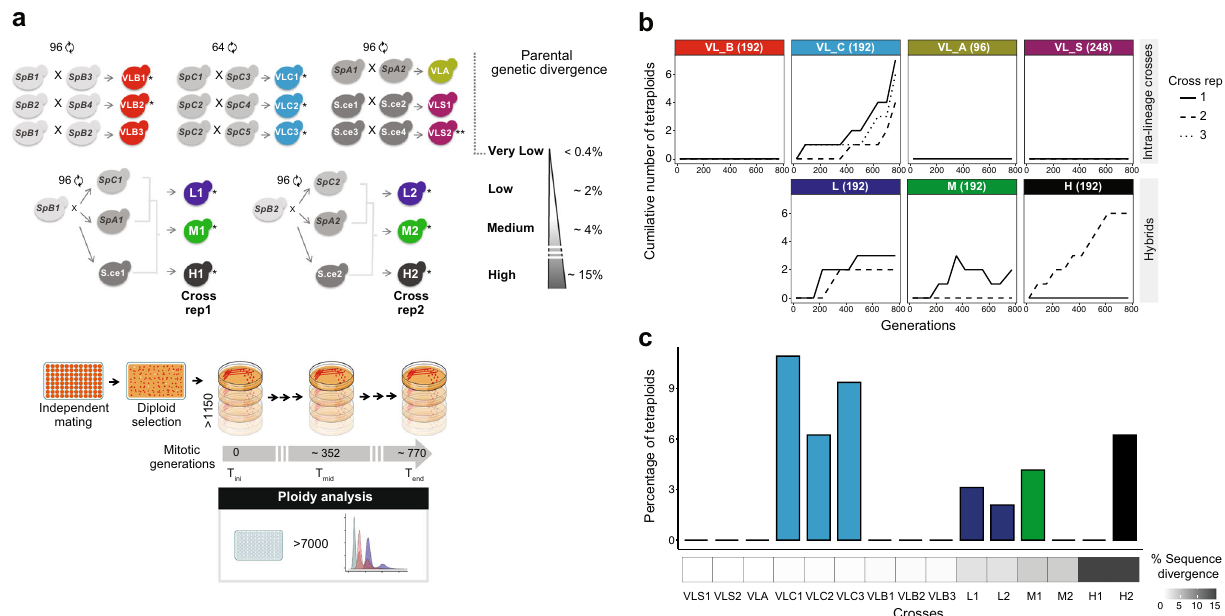
Fig. 1 Whole-genome duplication is genotype and cross speci fi c. a Crosses among S. paradoxus incipient species (VL_B, VL_C, VL_A, L, and M), among S. cerevisiae isolates (VL_S) and between these two distant species (H). Most types of crosses involve two to three biological replicates, and each individual cross was performed independently 48 – 96 times to represent independent matings. We also included 152 MA lines derived from a homozygous diploid S. cerevisiae strain (VL_S2) propagated for ∼ 2062 generations 58 . Crosses are labeled with a star according to their source * 52,57 and ** 58 . The 1304 lines were evolved under relaxed selection. Mitotic propagation was performed through repeated single-cell bottlenecks and ploidy was measured using fl ow cytometry at different generation timepoints. b Cumulative number of tetraploid lines observed along the experiment. Numbers in parentheses represent the number of biologically independent studied lines. c Whole-genome duplication rate differs among crosses (VL_C1 ( n = 7), VL_C2 ( n = 4), VL_C3 ( n